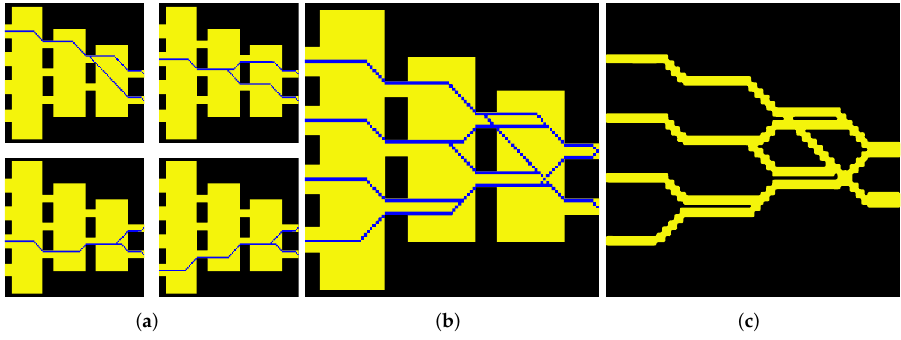
Figure 18. ( a ) Input to output shortest paths. ( b ) Compound of the resulted shortest paths. ( c ) Final proposed gate topology after the area optimization.